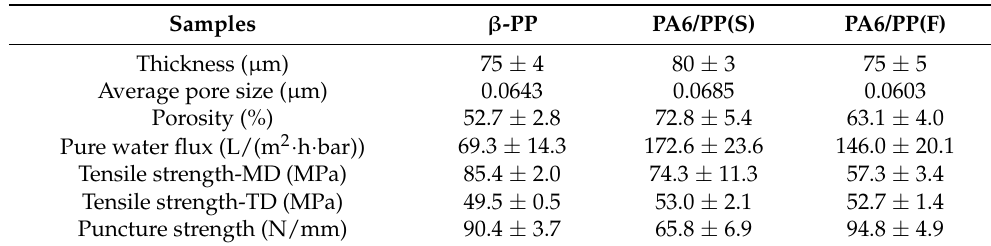
Figure 14. Pore size distribution curves of β -PP, PA6/PP(S), and PA6/PP(F) biaxial stretched mem- branes obtained via capillary flow porometry. Table 2. Thickness, average pore size, porosity, pure water flux, and mechanical properties of biaxially stretched